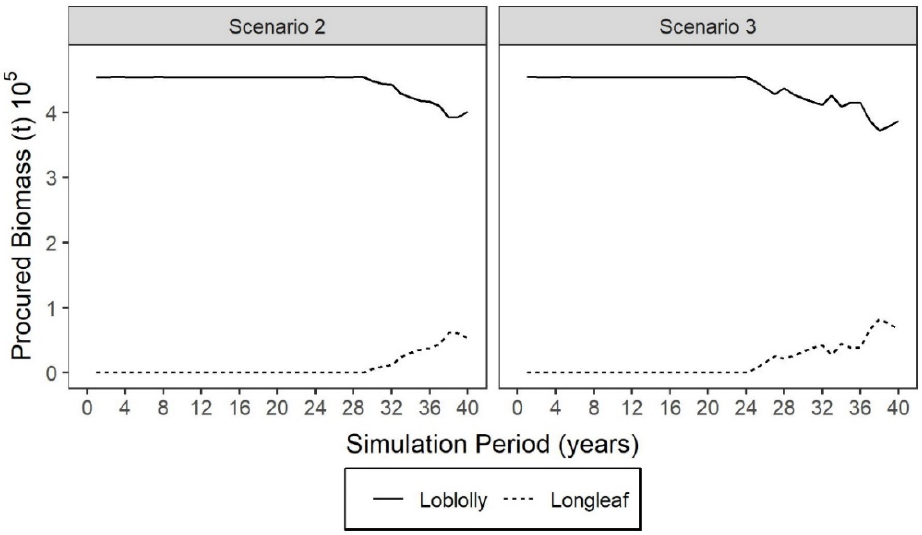
Figure 8. Distribution of pulpwood procured from each species over the simulation period. Results are reported only for Scenario 2 and Scenario 3, as longleaf pine is not present in the landscape in Scenario 1. Scenarios 2 and 3 are differentiated in Table 1.